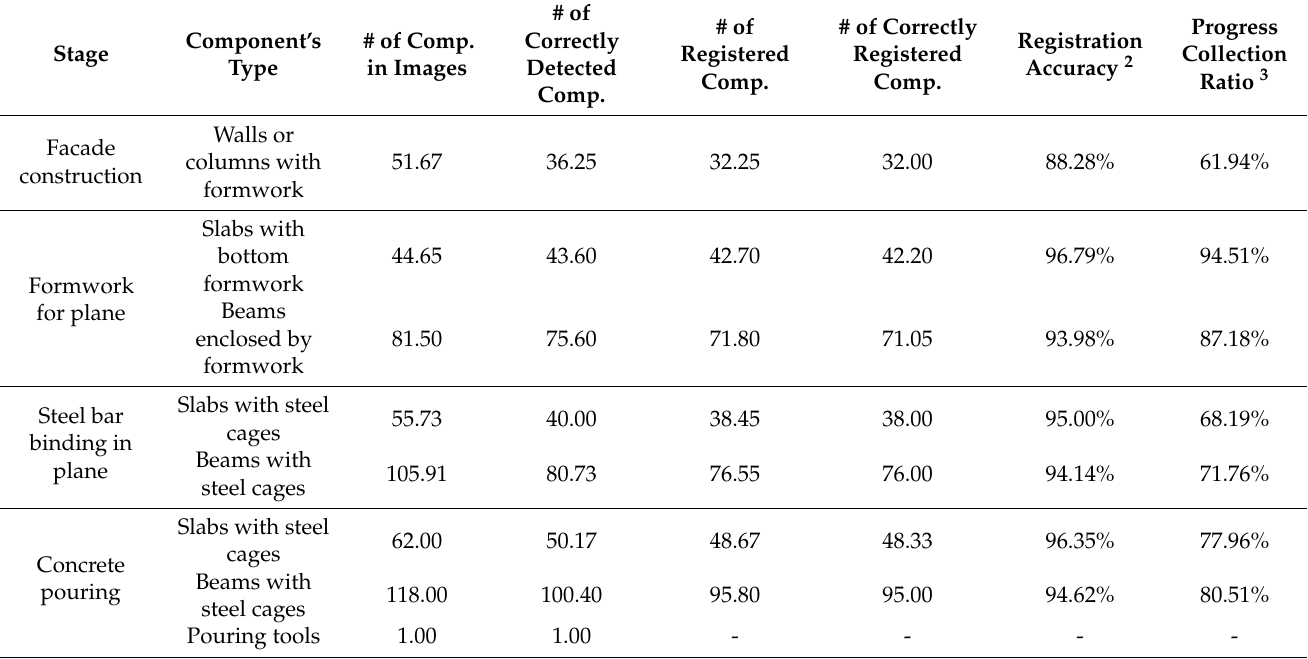
Table 4. Registration results 1